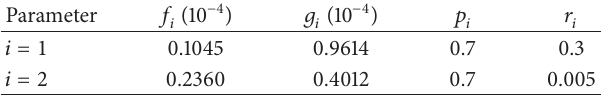
Table 4: Parameters of specific creep [26].